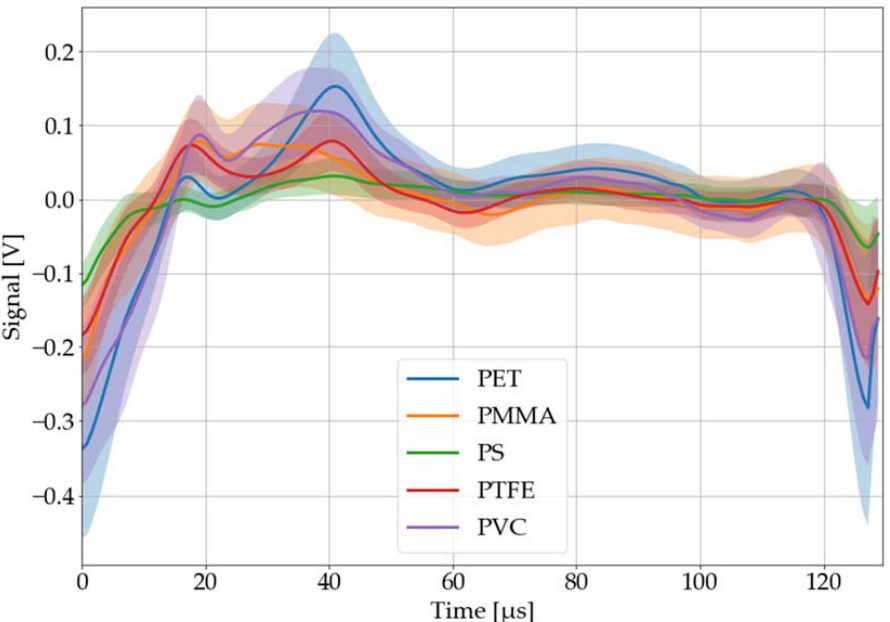
Figure 10. Black plastics with significant and potentially distinguishable laser-acoustic pulse re- sponses: PET, PMMA, PS, PTFE, and PVC. The laser-acoustic responses were recorded, processed, and averaged. The colored area around each graph corresponds to its 68% confidence